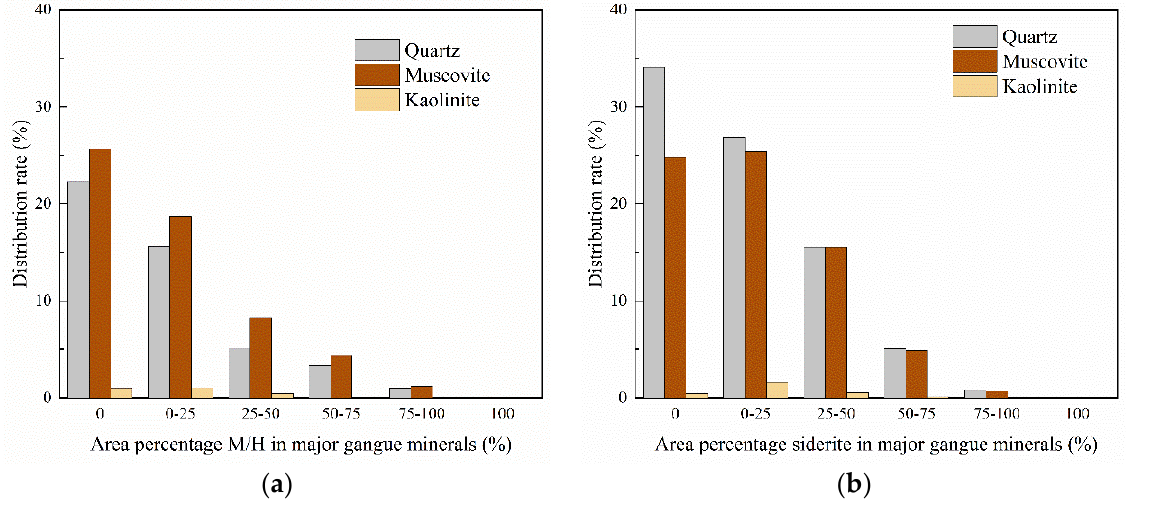
Figure 8. Intergrowth relationship between major gangue mineral and iron minerals ( a ) Intergrowth relationship between major gangue mineral and M/H; ( b ) Intergrowth relationship between major gangue mineral and